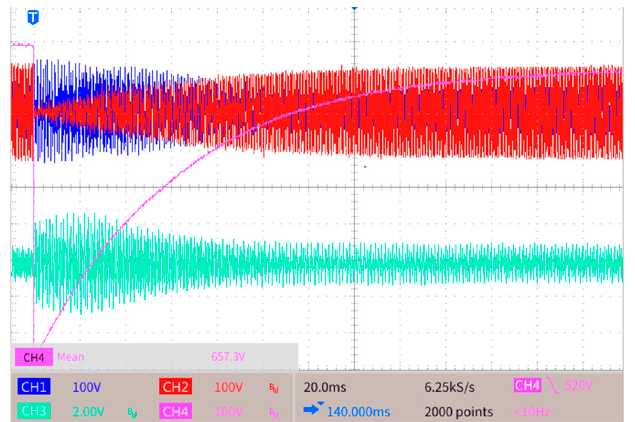
Figure 16. Resonant converter operation after output discharge by the spark gap (output voltage, primary voltage of the transformer, resonant capacitor voltage and current of the resonant tank).